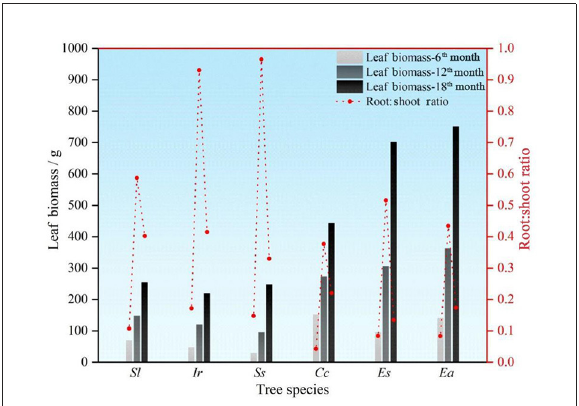
FIGURE6 Leaf biomass (g) and root:shoot ratios of all the six tree species in the 6, 12, and 18th month since plantation. The abbreviations of Sl , Ir , Ss , Cc , Es , and Ea were short for Sterculia lanceolata , Ilex rotunda , Schima superba , Cinnamomum camphora , Elaeocarpus sylvestris , and Elaeocarpus apiculatus . The light gray, medium gray, and black bars represent the leaf biomass that follow the left Y -axis and the red dotted-line representing the development of root:shoot ratios match the right red Y